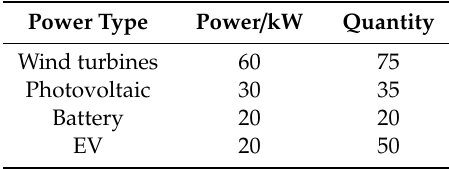
Table 2. Distributed power parameters.